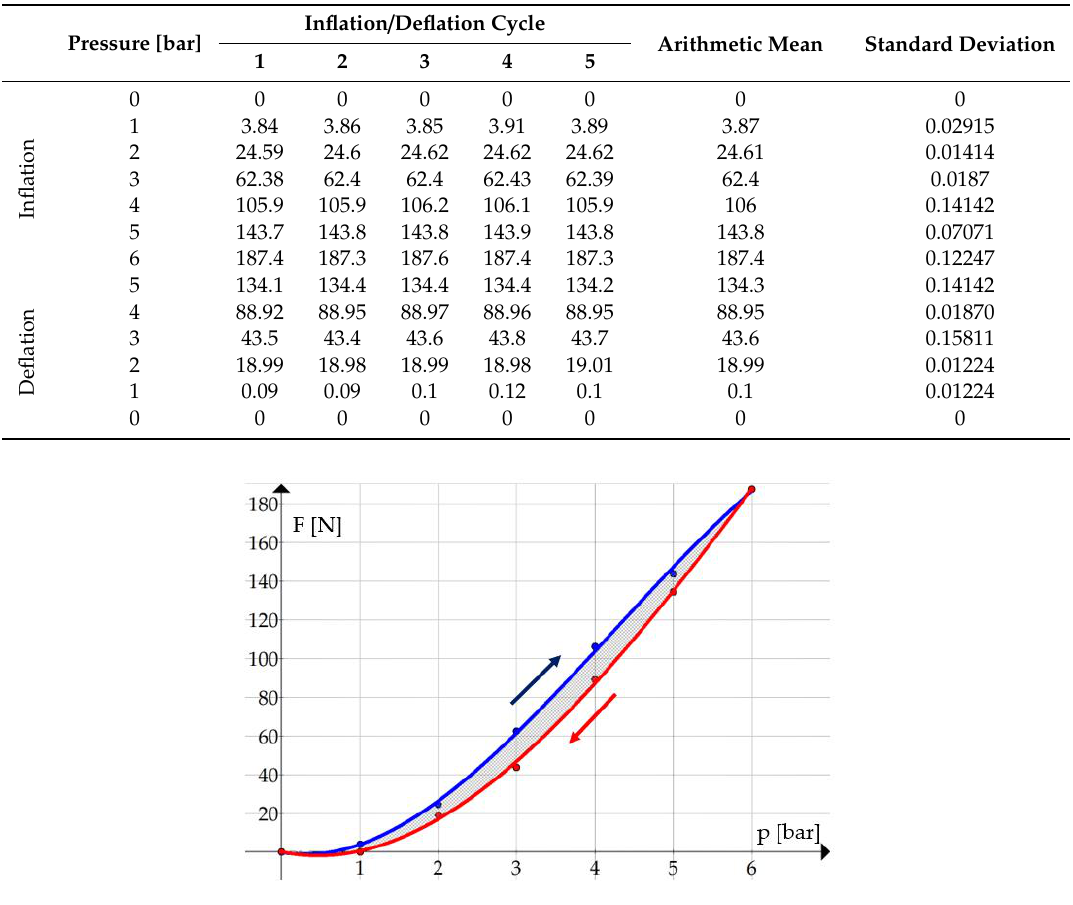
Figure 11. Variation of the forces developed by the pneumatic muscle versus pressure. The values obtained for the standard deviation reveal a low measurement uncertainty.